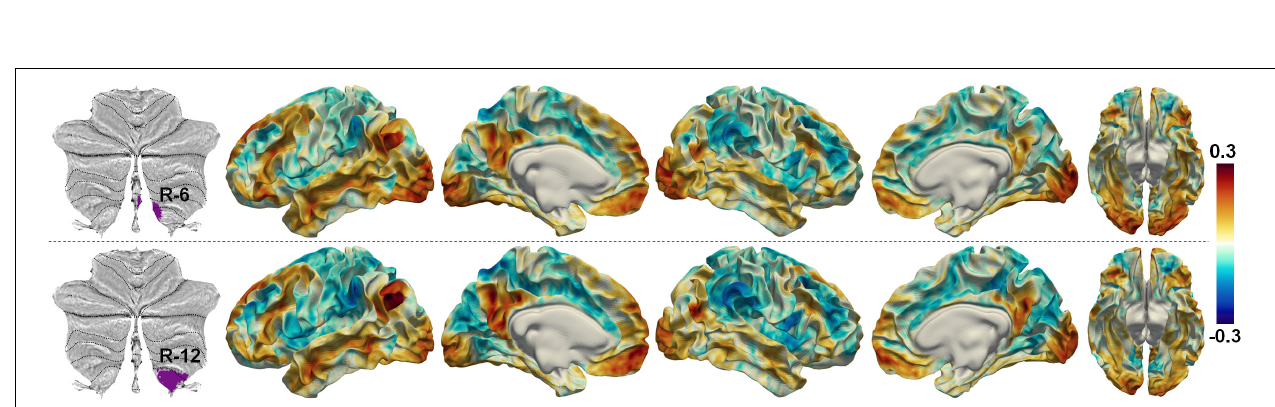
FIGURE 10 | The cerebellum–cerebrum functional connectivities of two regions on the right cerebellum.